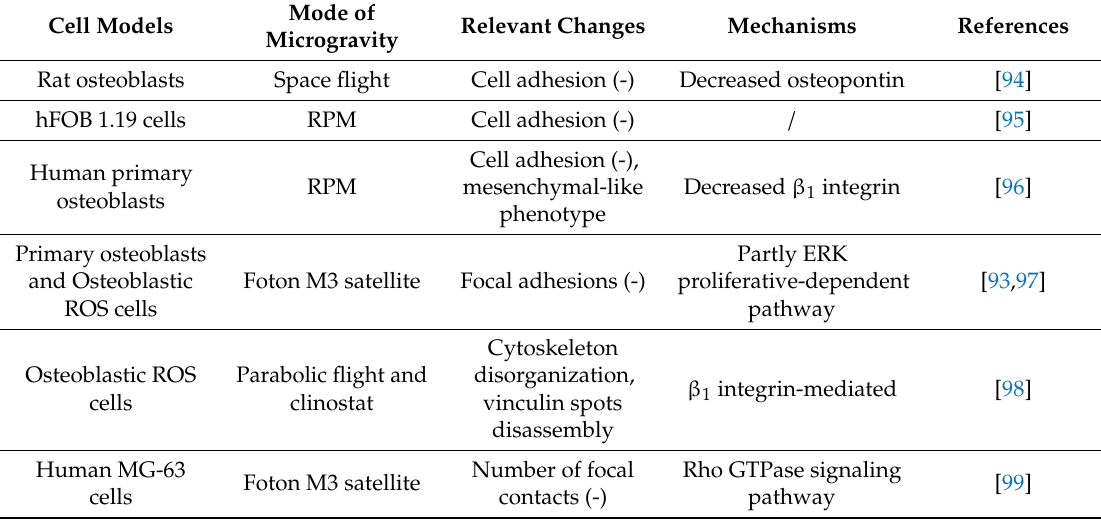
Table 6. E ff ects of microgravity on bone cells